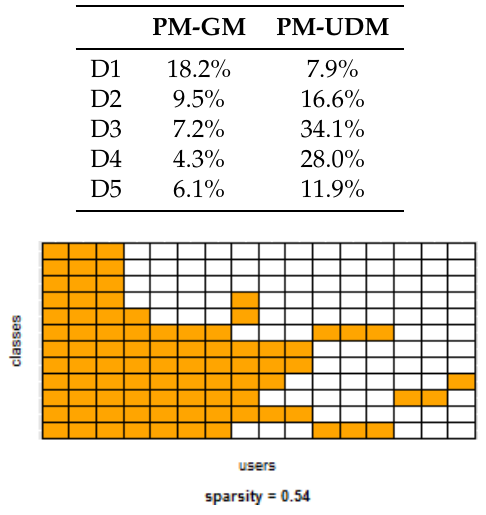
Figure 6. D2: Wrist sensor dataset user-class sparsity